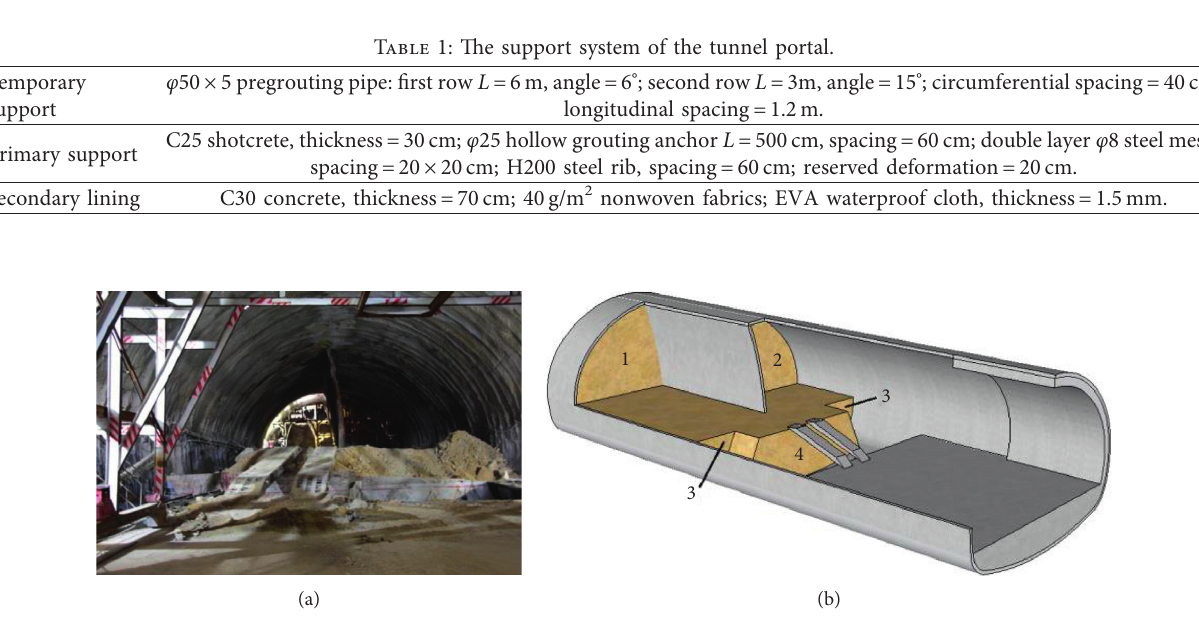
Figure 4: Construction of upper bench CD method. (a) Field construction. (b) Three-dimensional schematic